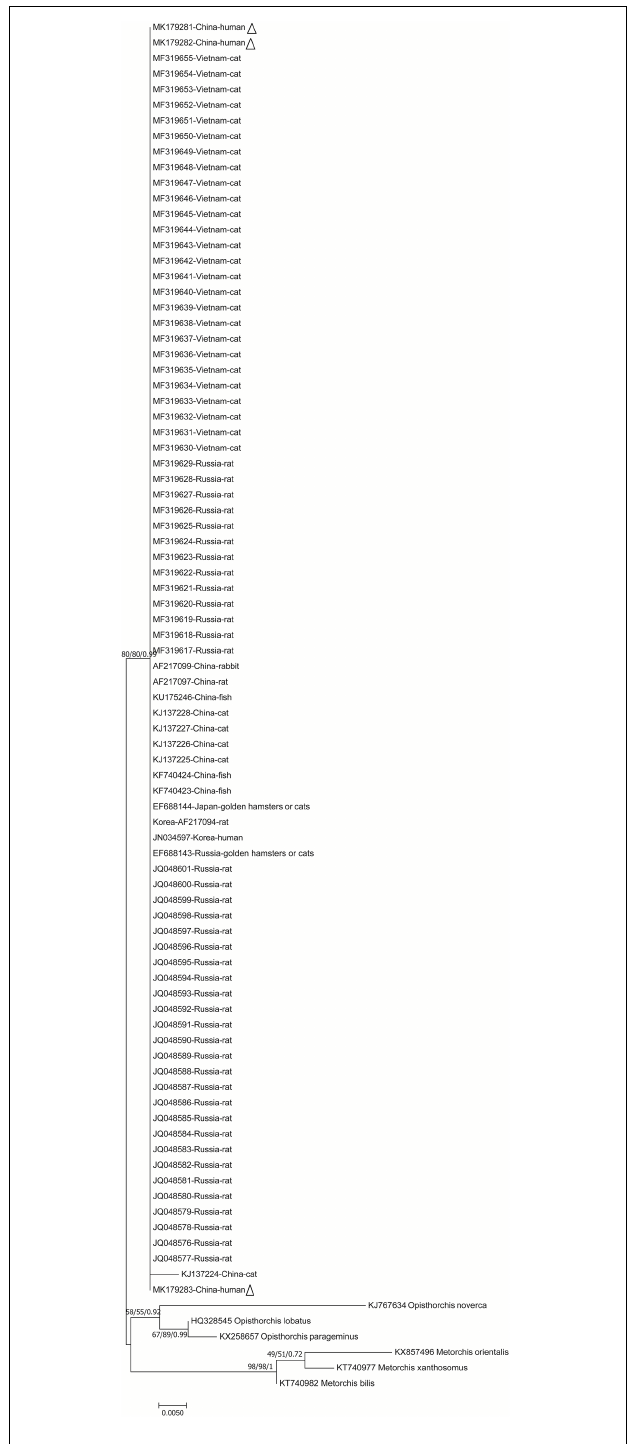
FIGURE 3 | Phylogenetic relationships between the C. sinensis isolates based on the partial ITS2 rDNA sequences. Nodal support of > 50% is shown for maximum likelihood/neighbor-joining/Bayesian Inference analyses (as indicated). Opisthorchis noverca and Opisthorchis lobatus et al. were used for comparison. Each sequence is identified by its accession number and host origin. Genotypes with black triangle are genotypes identified in this study,